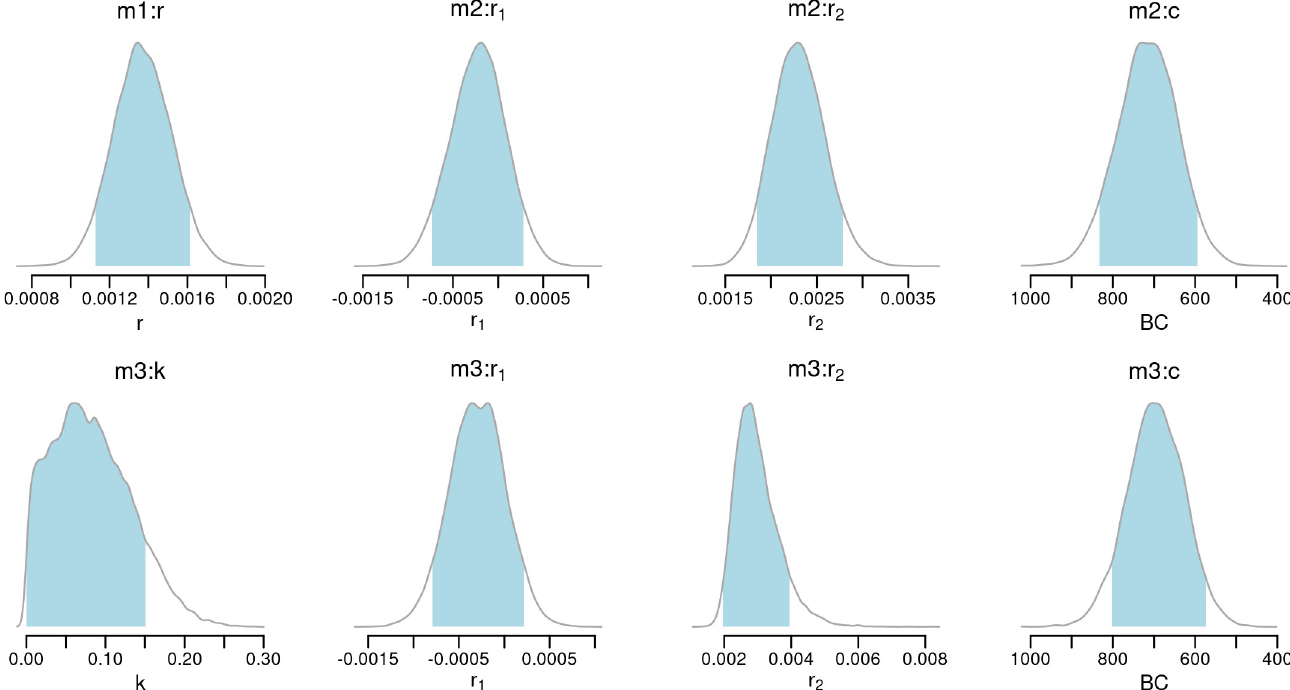
Fig 7. Marginal posterior distributions of fitted growth parameters for models